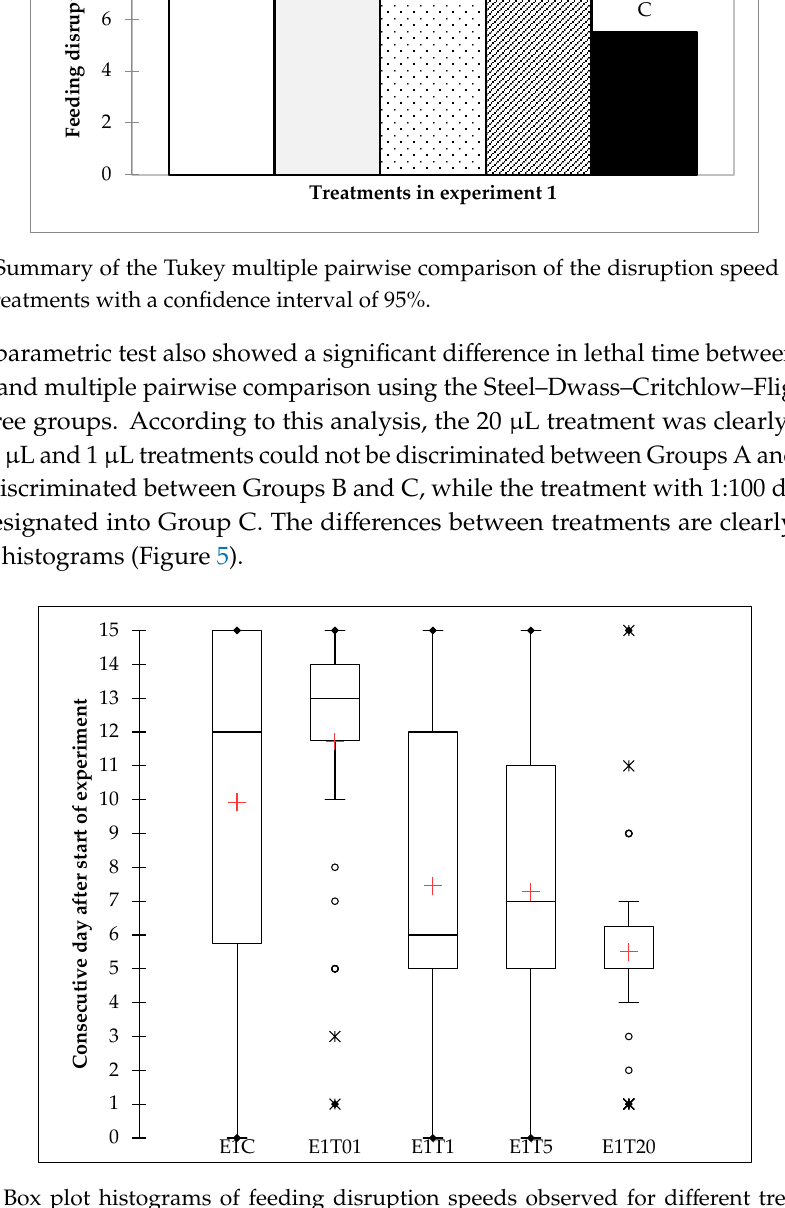
Figure 5. Box plot histograms of feeding disruption speeds observed for different treatments in experiment 1. The 20 μL treatment showed the lowest mean and dissipation of data, followed by 5 μL and 1 μL, while the 1:100 dilution showed the highest value, even higher than the control group. Cross represents the arithmetic mean, the central line of the box represents the median, the upper line of the box represents the third quartile, the lower line of the box represents the first quartile, outreaching lines represent standard deviations, dots represent outlayers.